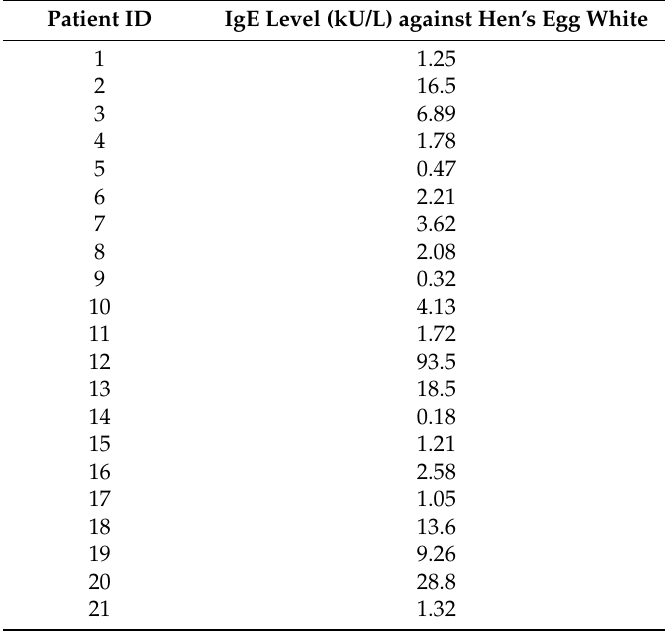
Table 1. Serum levels of specific immunoglobulin E (sIgE) against egg white determined by ImmunoCAP